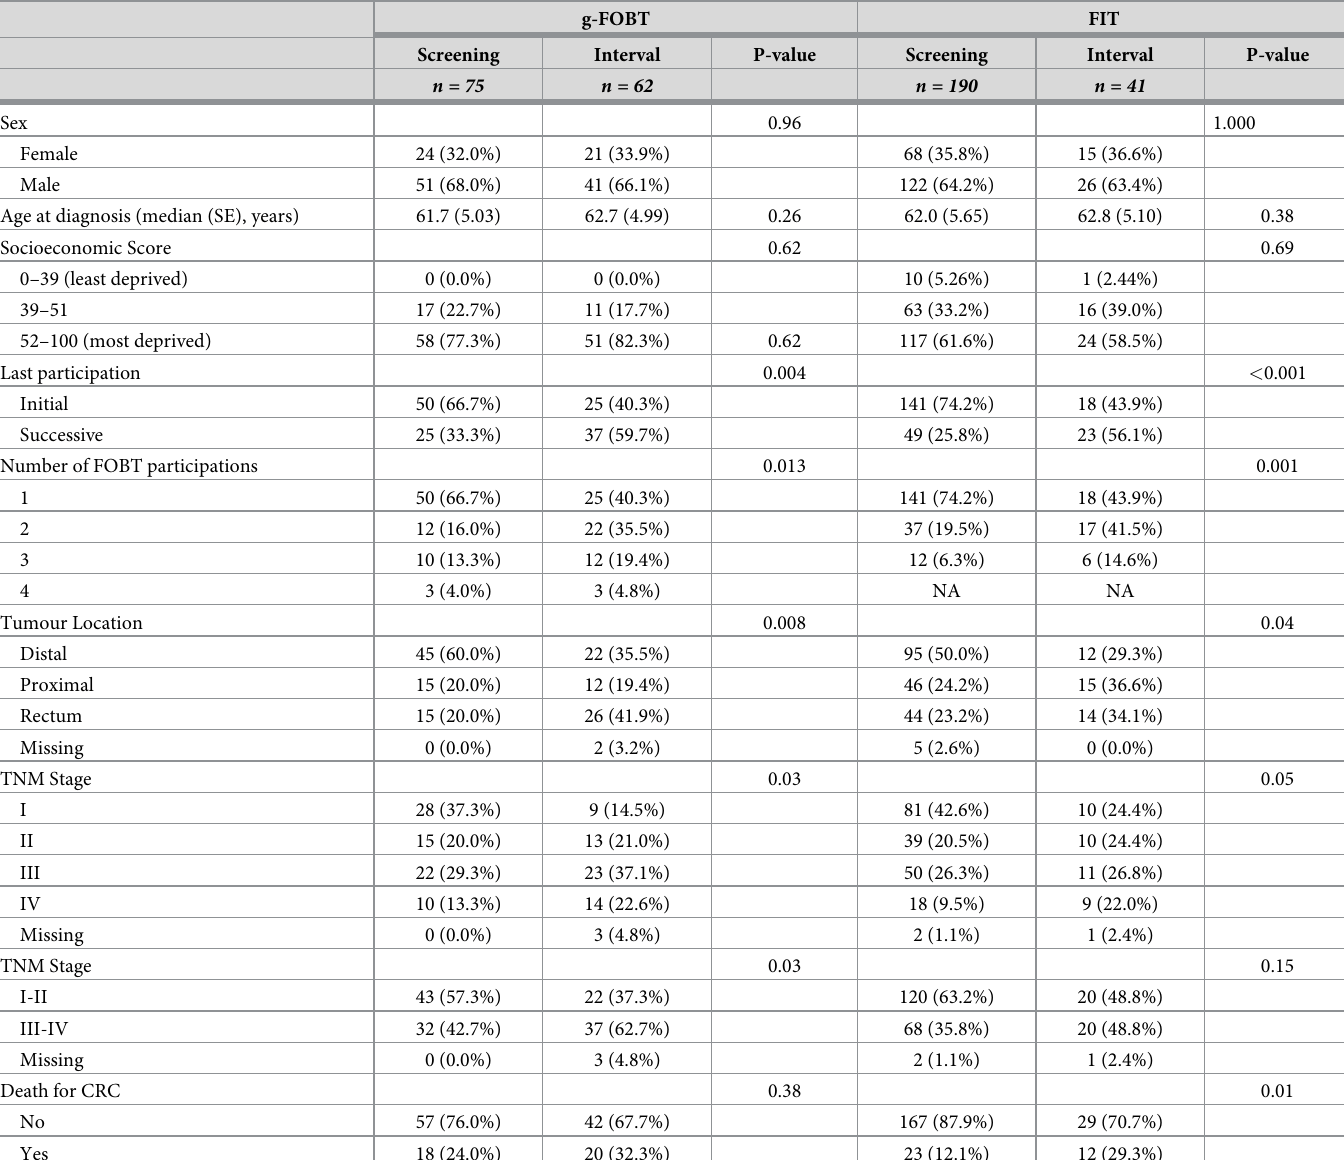
Table 4. Characteristics of colorectal cancer among participants according to type of faecal occult blood